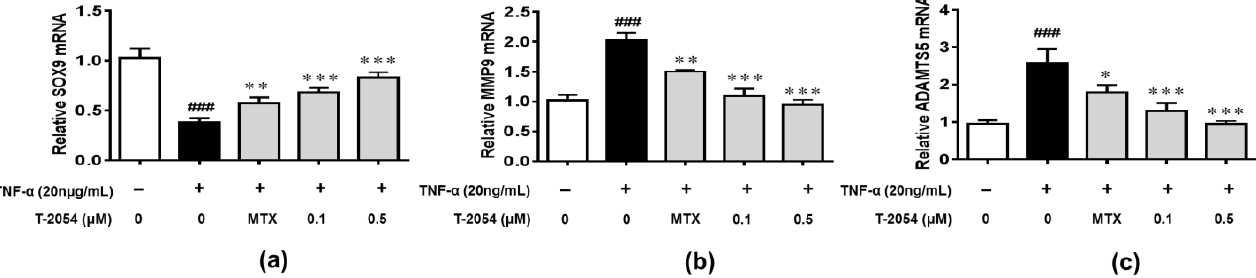
Figure 4. Gene expression of SOX9, MMP9 and ADAMTS5. ATDC5 cells were treated with TNF-α (20 ng/mL) or TNF-α with various doses (0, 0.1 and 0.5 μM) of T-2054 for 24 h. The total RNA was collected and mRNA levels of SOX9 ( a ), MMP9 ( b ) and ADAMTS5 ( c ) were analyzed by qPCR. Actin was used as an internal control to normalize the data. Each value represents the mean ± SD, performed in 3 different experiments. ### p < 0.001 vs. CON group; * p < 0.05; ** p < 0.01; *** p < 0.001 vs. TNF-α group.